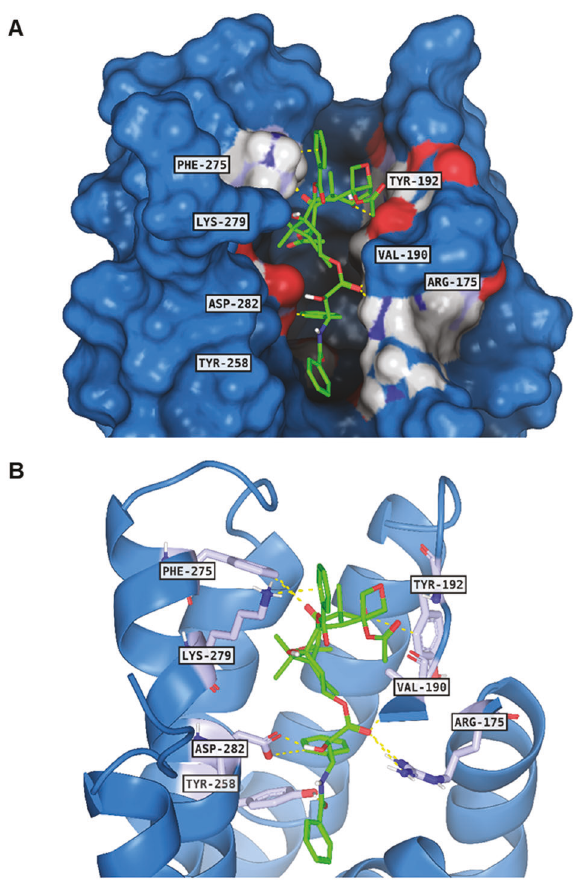
Fig. 1 Paclitaxel binding mode in C5aR1 binding site. The ligand between C5aR1 and paclitaxel is reported in green lines, while the protein structure is reported in blue surface ( A ) and cartoon ( B ). The contact residues and related hydrogen bonds are depicted in slate sticks and yellow dots,